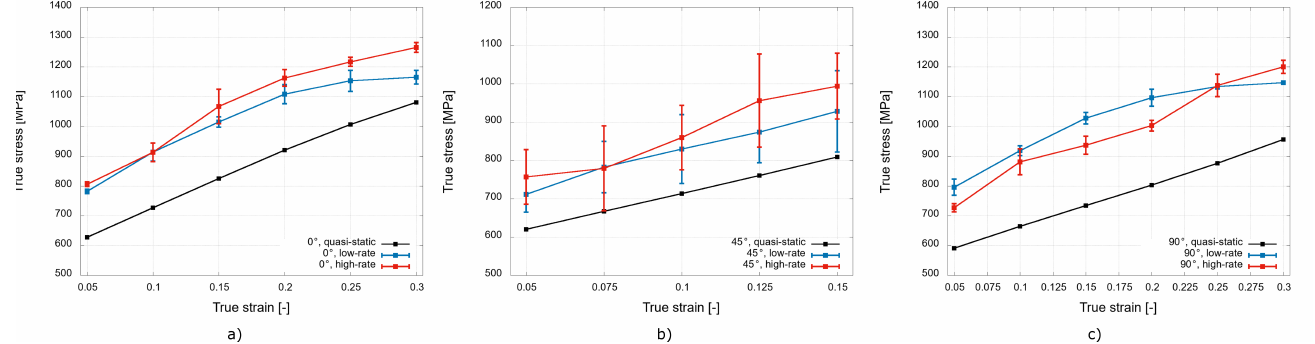
Figure 6. Detailed plastic region of the true stress–true strain diagrams: ( a ) 0 ◦ ; ( b ) 45 ◦ ; and ( c ) 90 ◦ printing